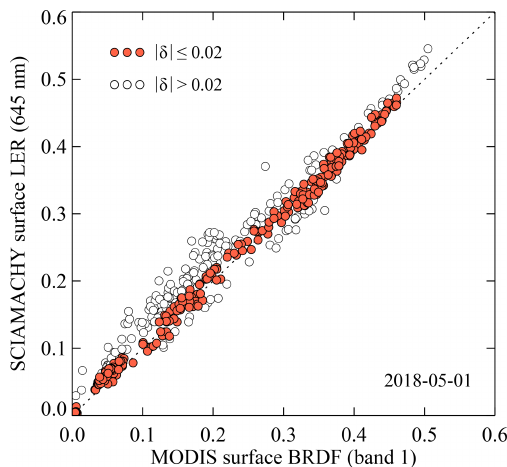
Figure 5. SCIAMACHY surface LER at 645nm versus MODIS surface BRDF from MODIS band 1 (centred around 645nm), for cloud-free conditions and land surfaces observed by TROPOMI on 1 May 2018. The red circles indicate observations for which there is good agreement ( | δ 645 | ≤ 0 . 02). These are used in Method